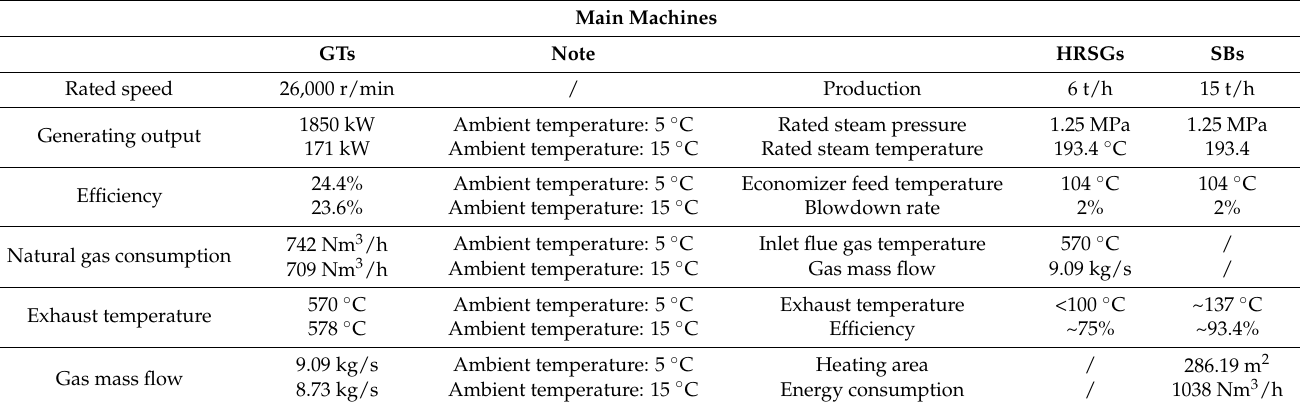
Table 1. The device parameters of the CHP